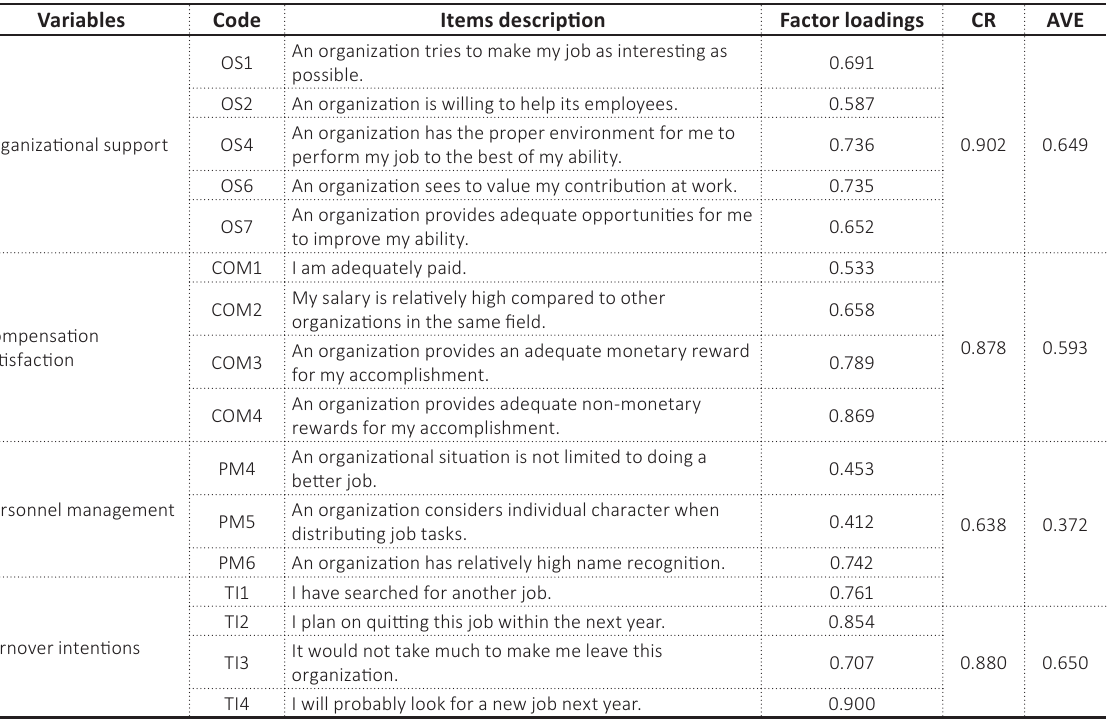
Table 2. Construct validity and